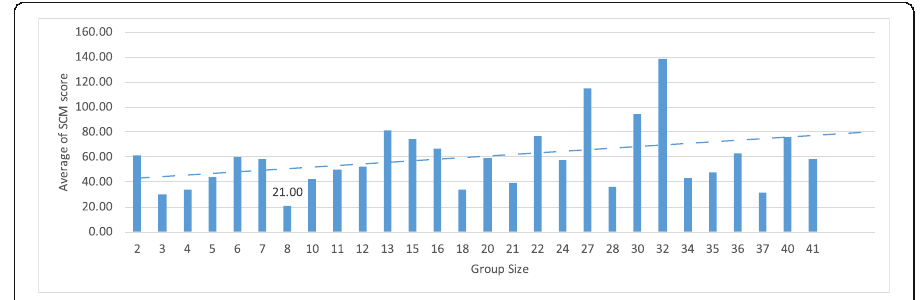
Fig. 7 Distribution of SCM group size and scores